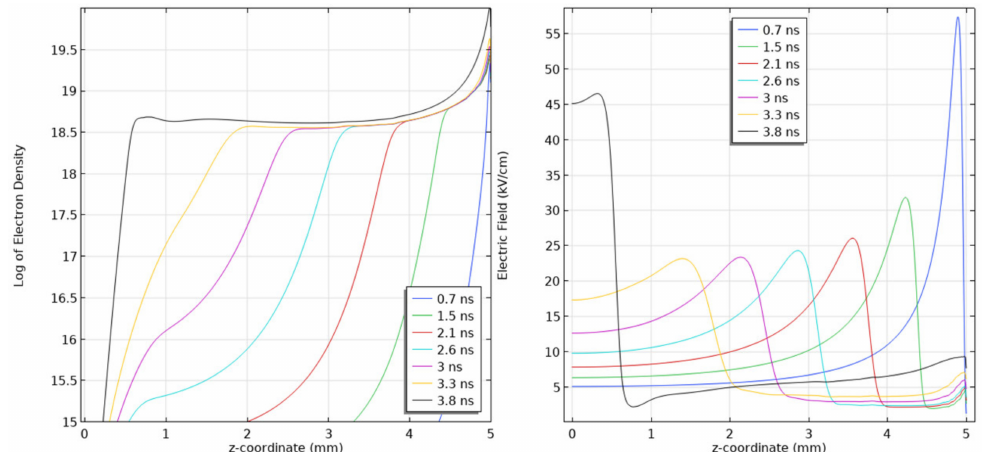
Figure 12. Line diagrams along the symmetry axis of the log of the Electron Density profile ( left ) and its corresponding Electric Field distribution ( right ) for a streamer propagating in a 5 mm air gap at a pressure of 10 kPa. Applied voltage of 5 kV. Scaling parameter for density profiles: 20 on logarithmic plot represents a density value of 10 20 m − 3